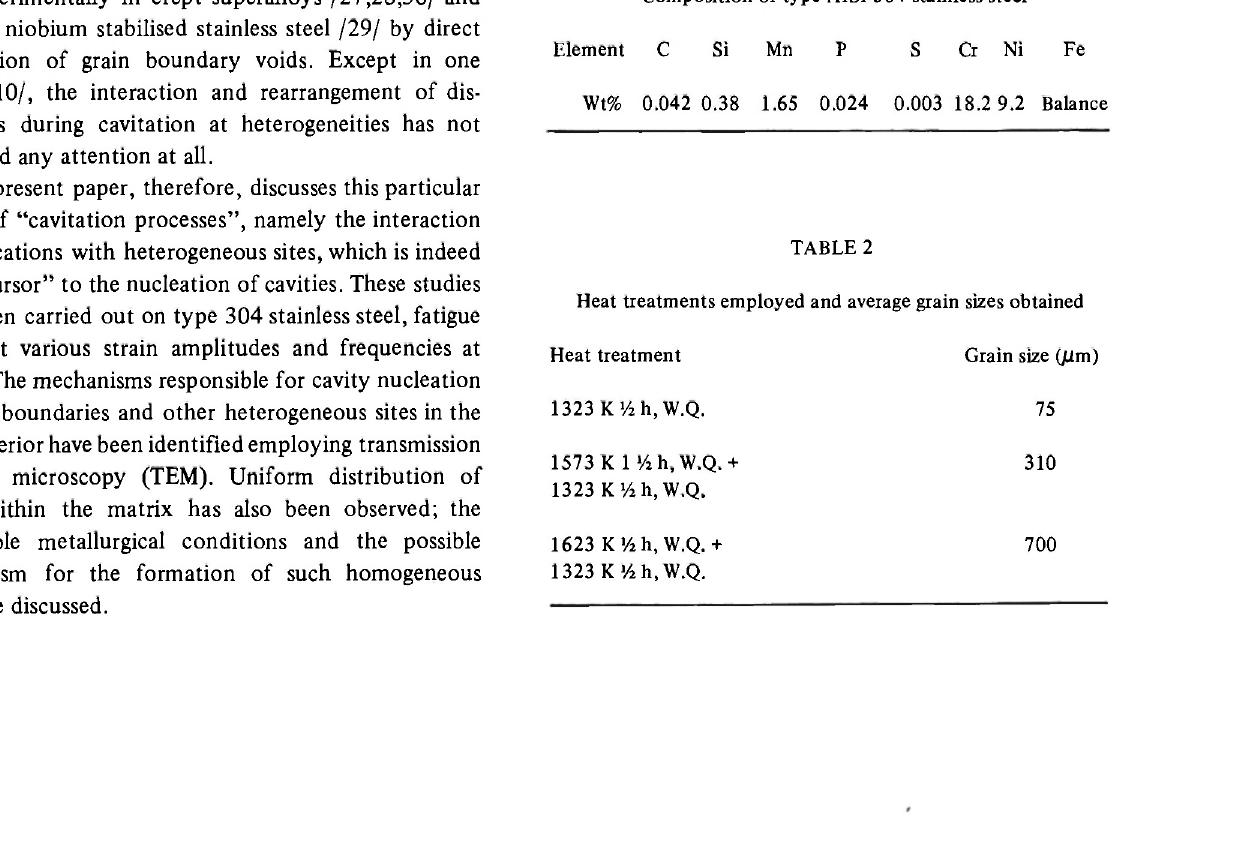
Heat treatments employed and average grain sizes obtained Heat